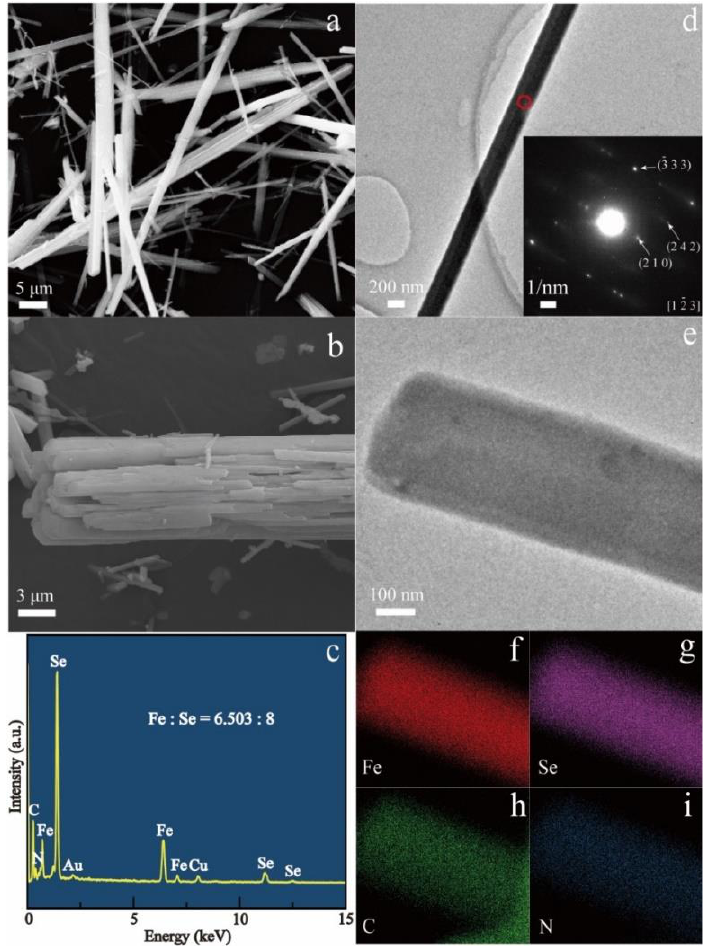
Figure 1. ( a , b ) SEM images and ( c ) the corresponding EDX spectrum of the (Fe 2 Se 3 ) 2 [Fe(dien) 2 ] 0.9 hybrid rods. ( d ) Typical TEM image of a single hybrid rod. Inset shows the corresponding SAED pattern. ( e ) A STEM image and corresponding element mapping of ( f ) Fe, ( g ) Se, ( h ) C and ( i ) N for a single (Fe 2 Se 3 ) 2 [Fe(dien) 2 ] 0.9 hybrid rod.